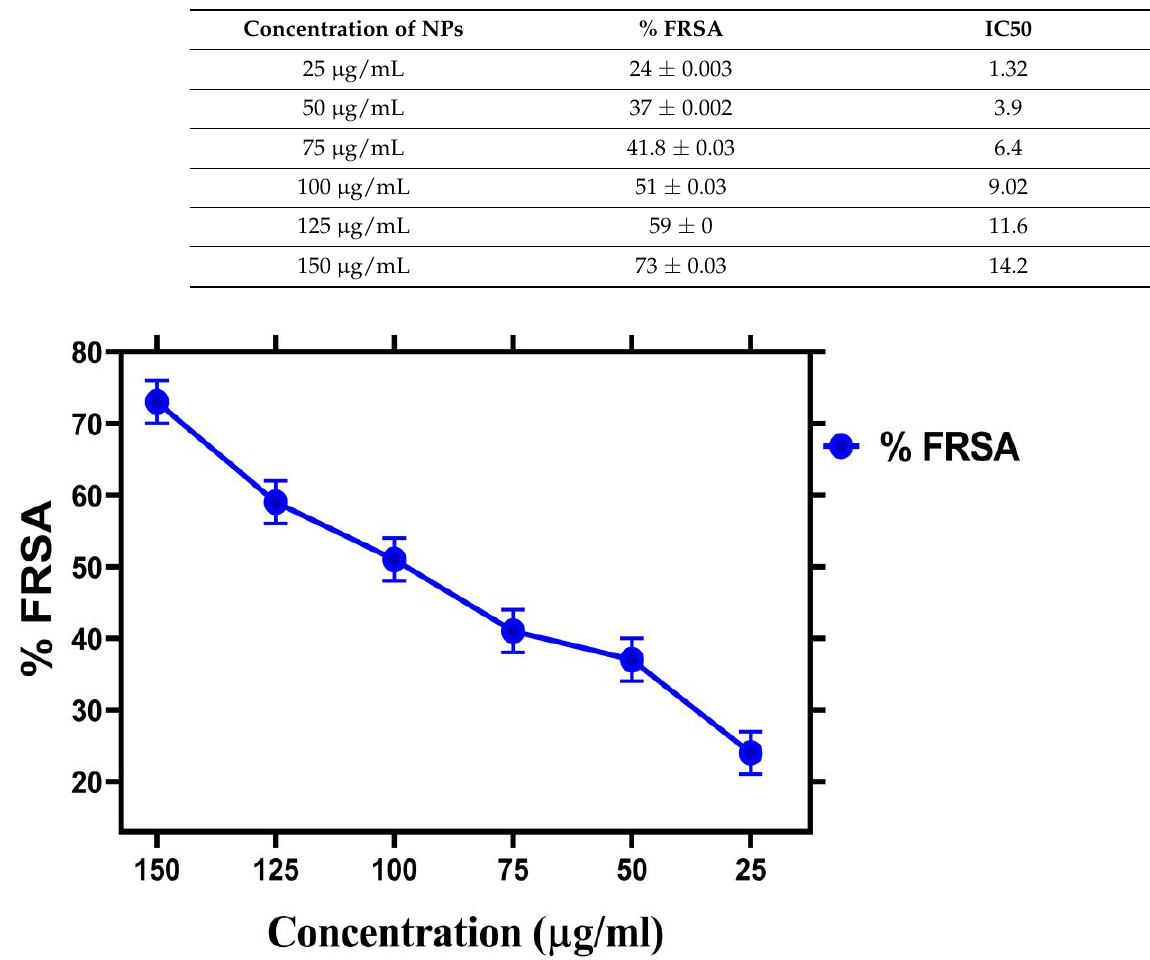
Figure 9. Antioxidant potential of a synthesized IONPs.